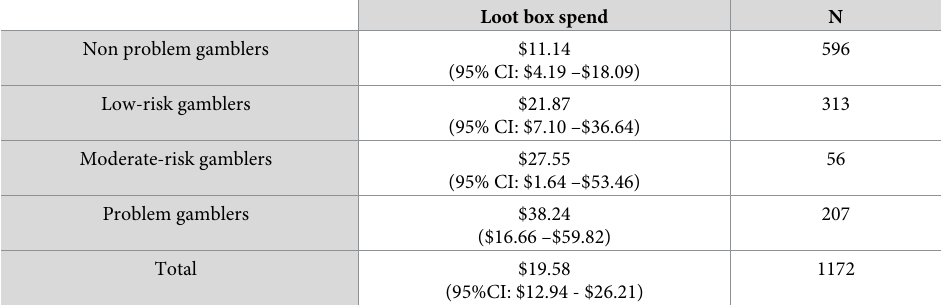
Table 1. Means and 95% confidence intervals for player spending on loot boxes, split by problem gambling severity.